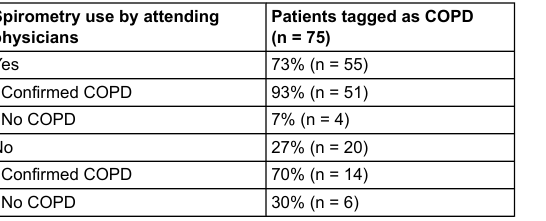
Table 2: Diagnostic use of spirometry by attending physicians in pa- tients tagged as chronic obstructive pulmonary disease (COPD).